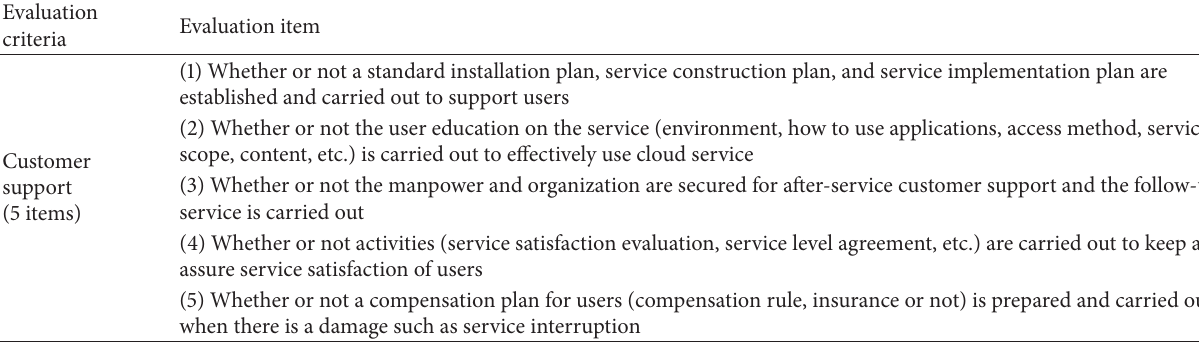
Table 14: Evaluation items of customer support.